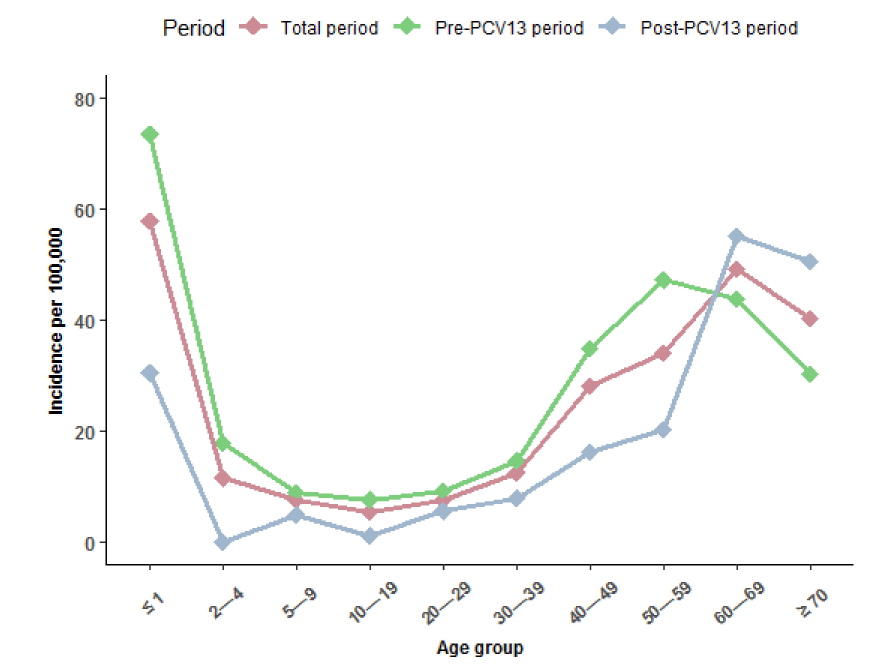
Figure 2. Annual incidence of invasive pneumococcal disease (IPD) per 100,000 person years by age group in Greenland 1995–2020, overall (dark pink line), pre (1995–2010) (light green line), and post (2010–2020) (gray line) introduction of the 13-valent pneumococcal conjugate vaccine (PCV13) to the childhood vaccination program in 2010 in